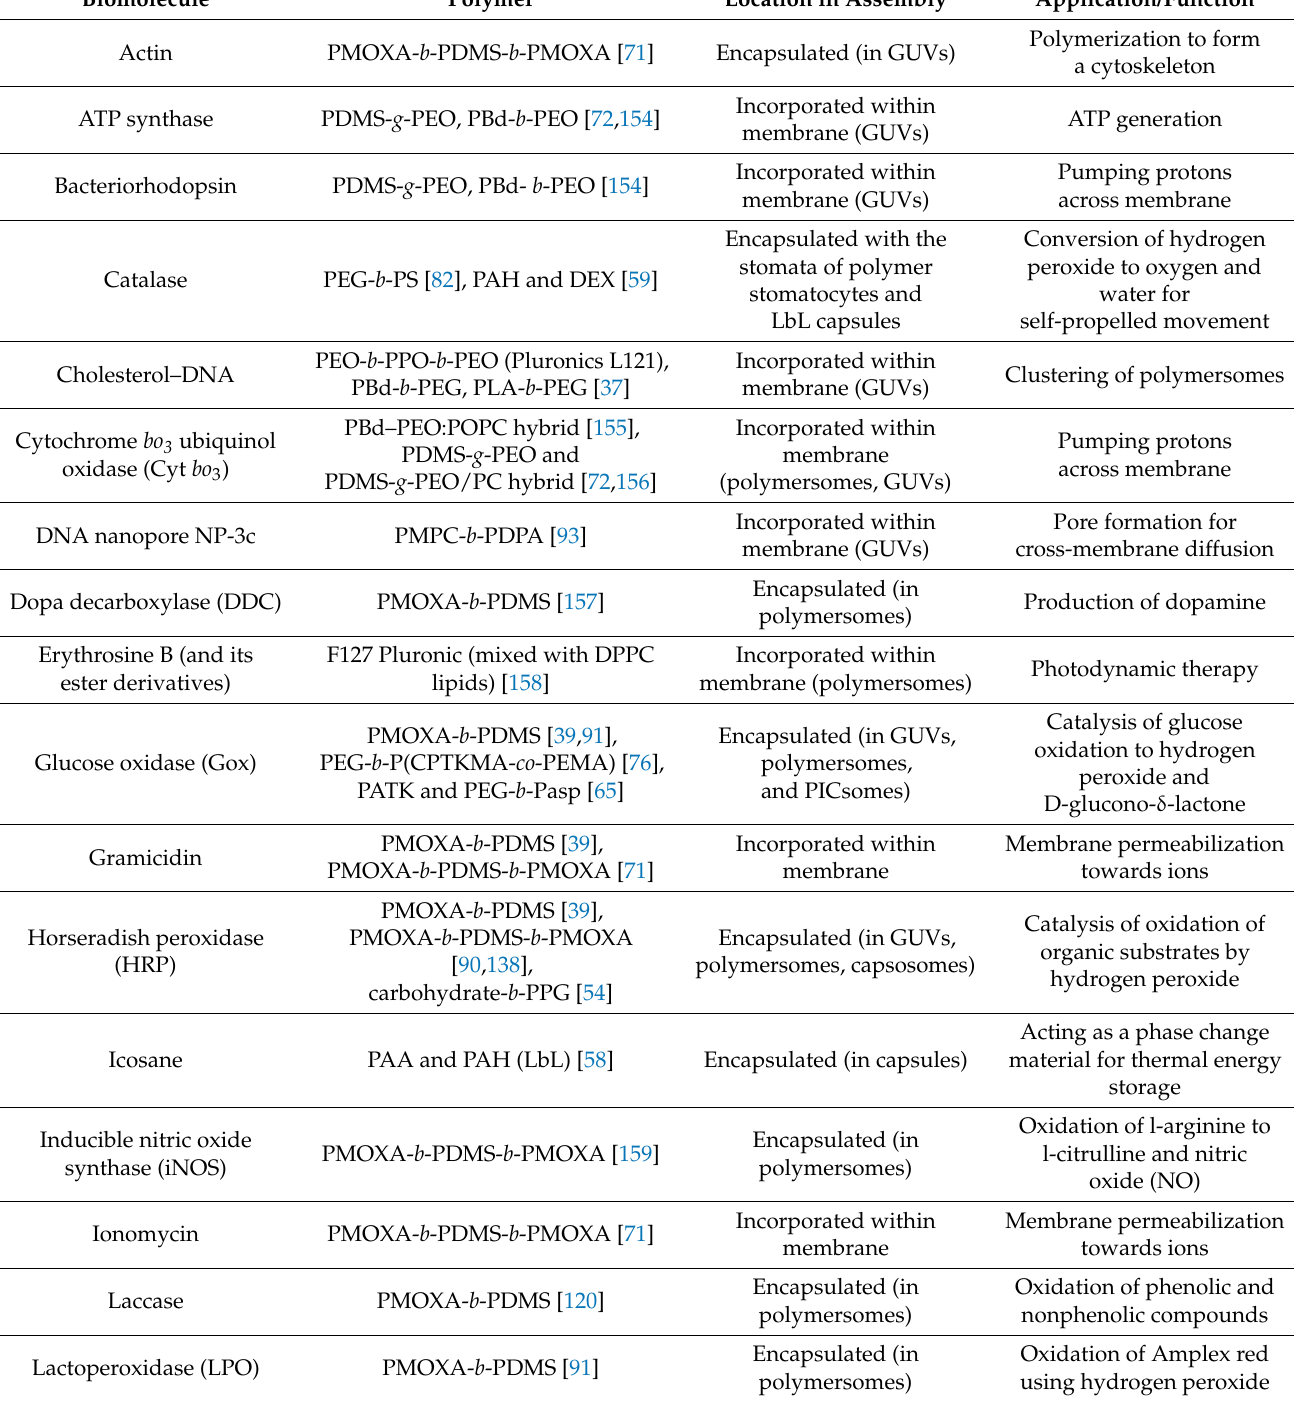
Table 2. Biomolecules and their applications in